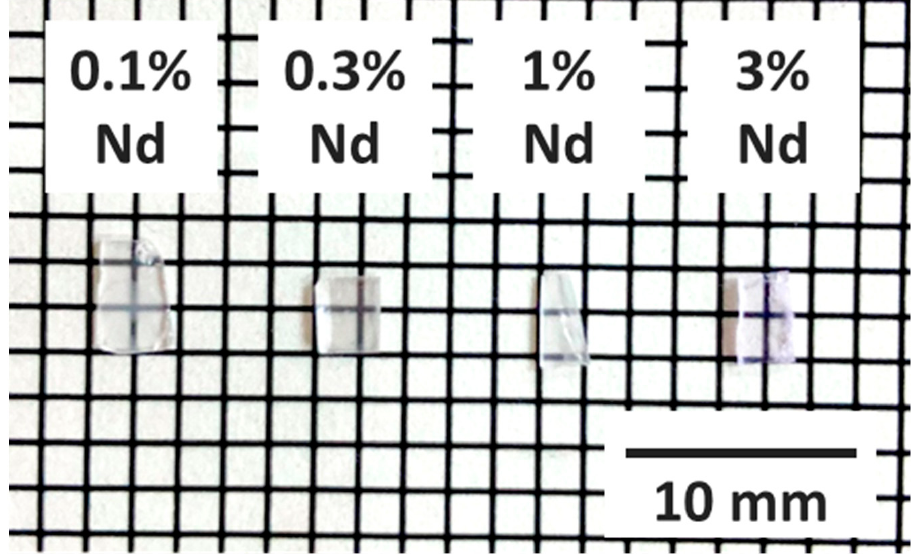
Figure 1. A photograph of the prepared LaMgAl 11 O 19 :Nd. The grid shows 2 mm intervals per divi- sion.